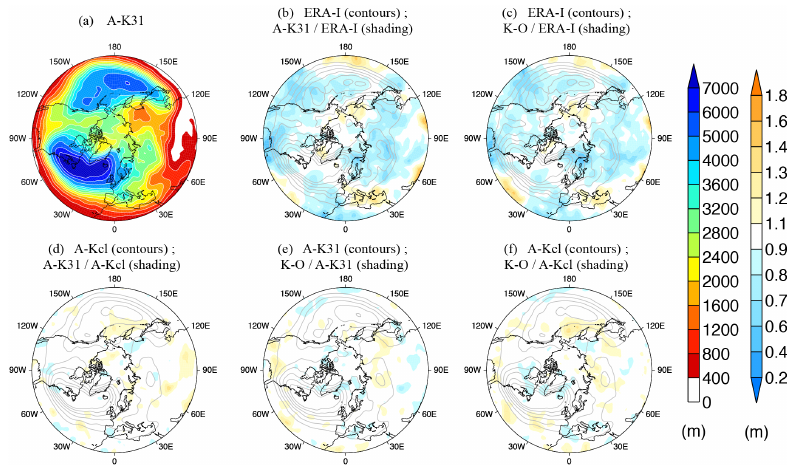
Figure 9. Standard deviation in wintertime (DJF) 2–6-day bandpass-filtered 500hPa geopotential height over the Northern Hemisphere from A-K31 (a) . Ratio of standard deviations from A-K31 and ERA-Interim (b) , K-O and ERA-Interim (c) , A-K31 and A-Kcl ( d ; impact of SST variability), K-O and A-K31 ( e ; impact of coupling) and K-O and A-Kcl ( f ; impact of both). Changes in variance are only shown where they are significant at the 95%